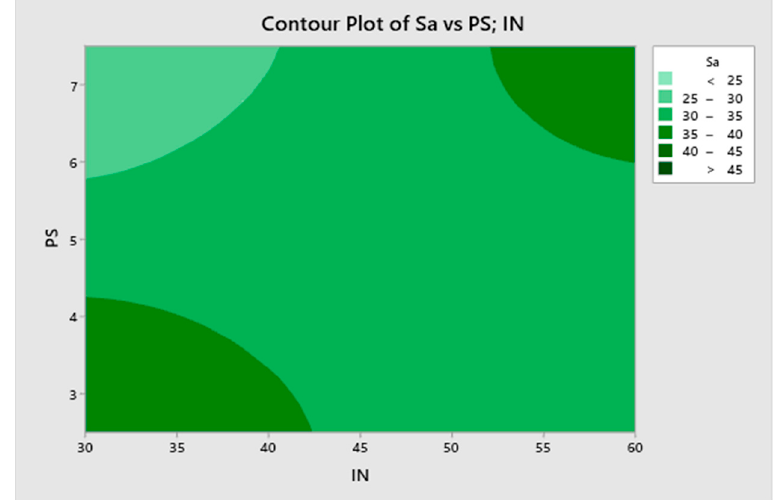
Figure 6. A contour plot of mean arithmetical roughness Sa ( μ m) vs. infill and printing speed.